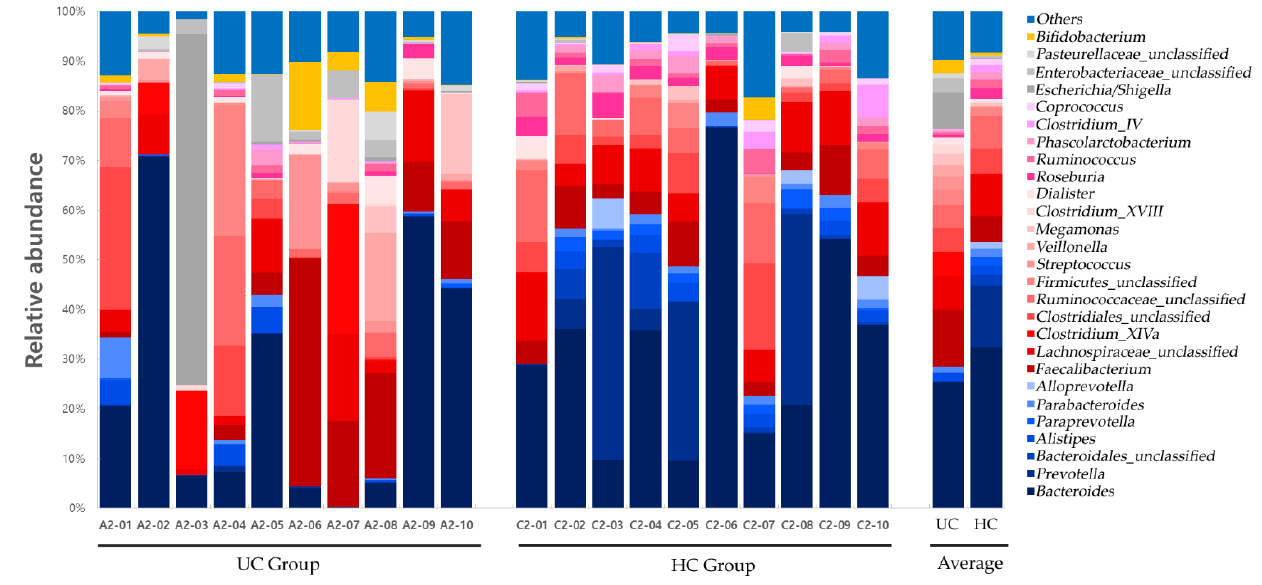
Figure 9. Gut microbiota composition at the genus level in UC and HC groups. UC, ulcerative colitis;